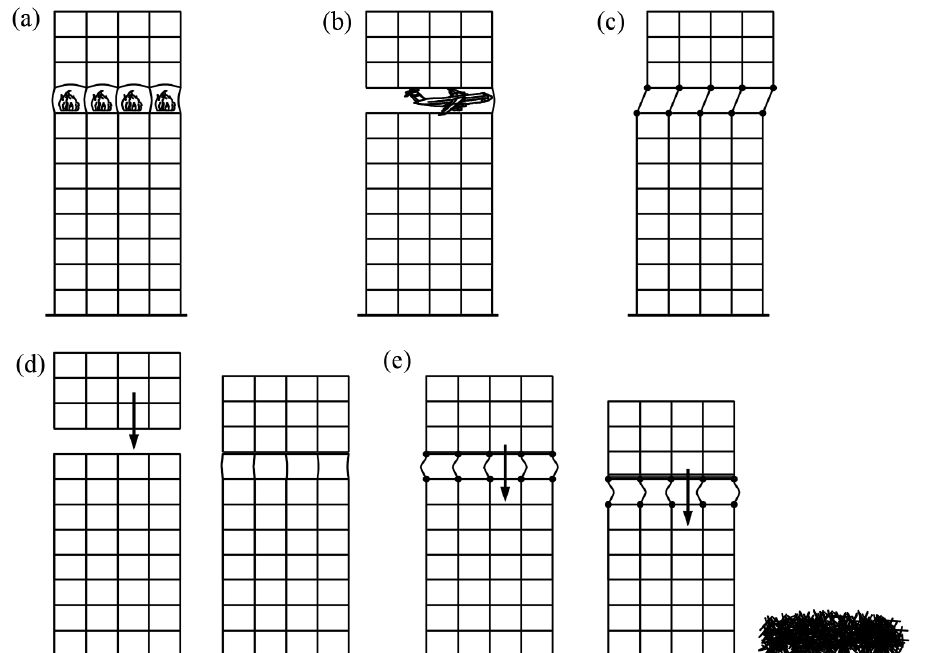
Figure 1. Possible triggering events that can lead to a progressive collapse of a building: ( a ) fire; ( b ) crash with an object or explosion; ( c ) strong earthquake—consequences of the removal of an entire story; ( d ) local failure does not lead to a progressive collapse due to a sufficient strength or ductility; ( e ) progressive collapse, insufficient strength, or ductility of remaining columns, based on [1].